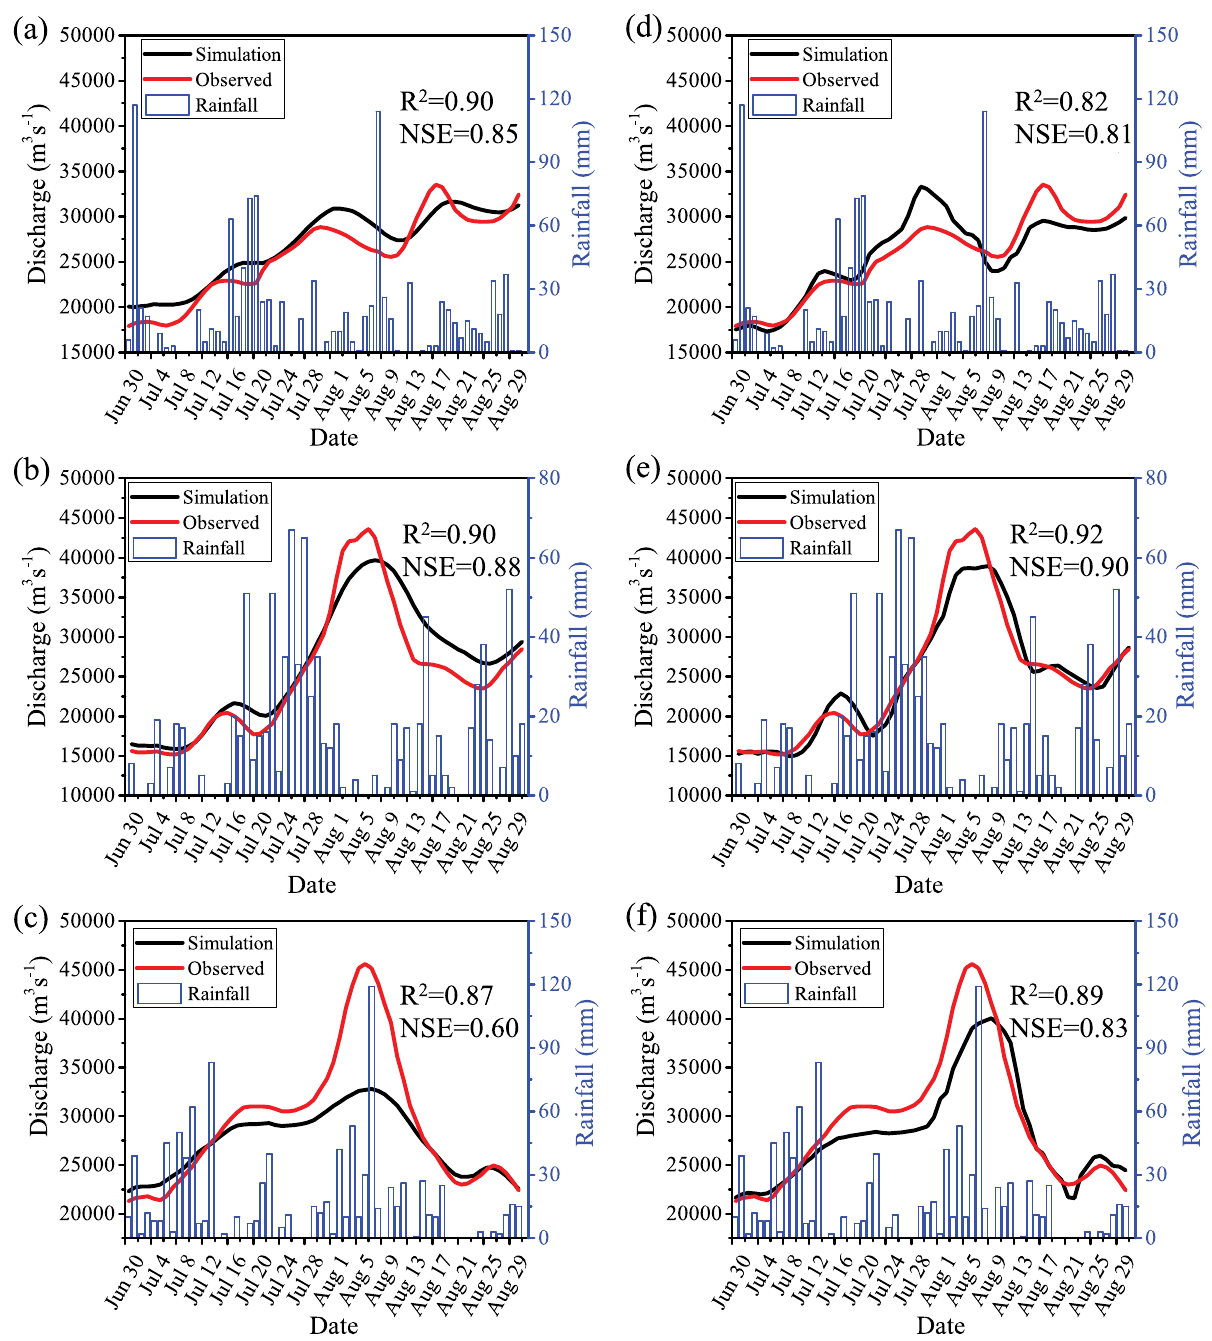
Fig 5. Comparisons of the simulated and observed discharges for the (a, d) 2011, (b, e) 2015, and (c, f) 2016 flood events at the Zalun station; (a)- (c) show the model results calibrated against the 2011 flood event, while (d)-(f) are the model results calibrated against the 2016 flood event, i . e ., the cross-calibration